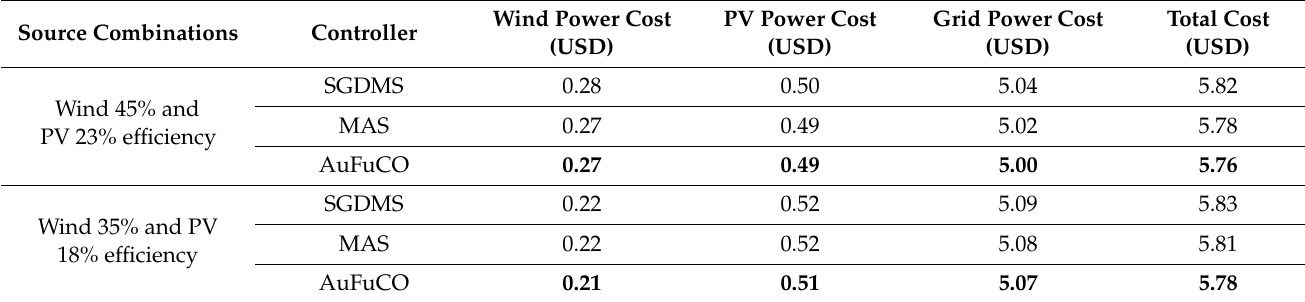
Table 7. Summary of results for the energy efficiency